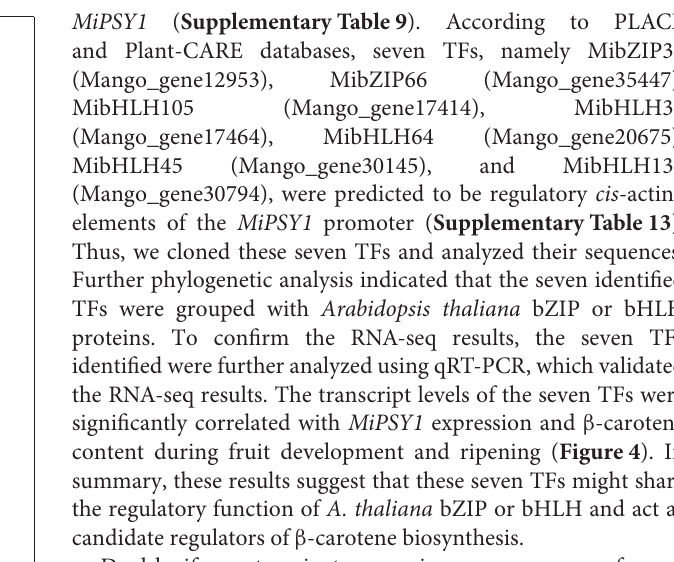
FIGURE 6 | Regulatory effects of selected transcription factors (TFs) on MiPSY1 promoter by dual-luciferase assays. The ratio of luciferase (LUC)/Renilla luciferase (REN) of the empty vector plus promoter was set as